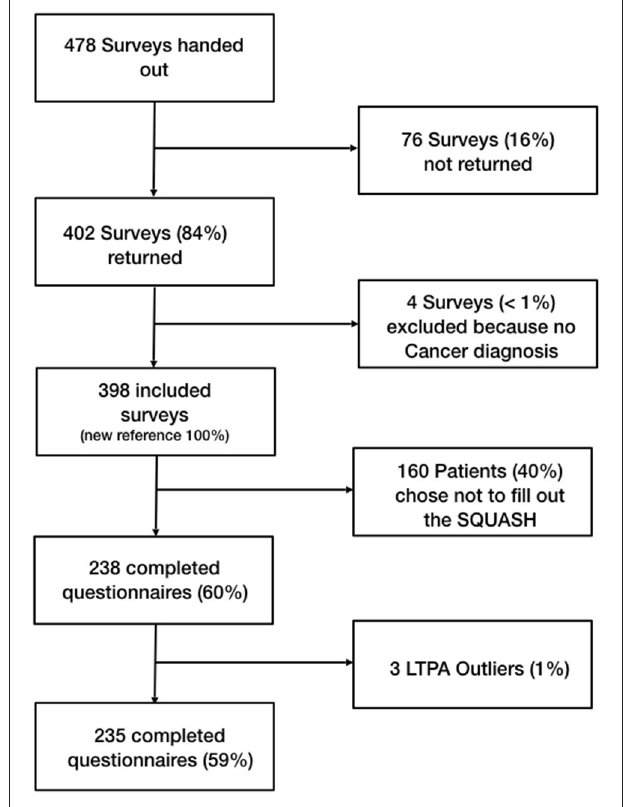
FIGURE 2 | Patient